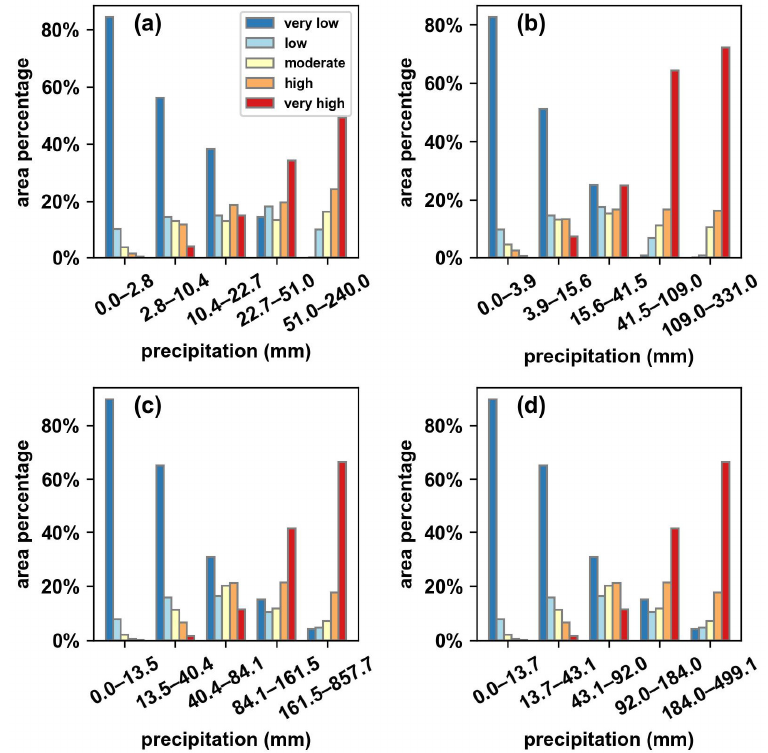
Figure 6. Area proportions of the five landslide susceptibility classes under different precipitation levels. Note: ( a ) Pr1d on 15 December 2020 ( b ) Pr1d on 15 June 2021 ( c ) Pr7d on 15 December 2020 ( d ) Pr7d on 15 June 2021.